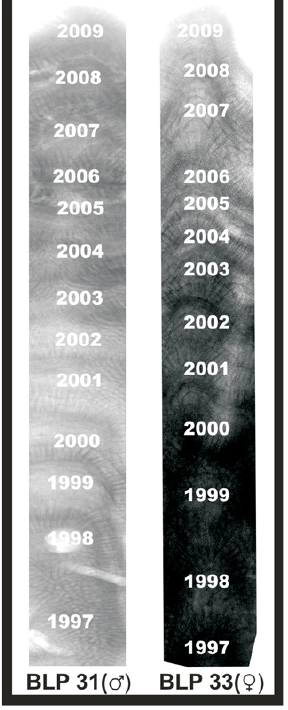
Figure 2. Positive X-Radiographs showing skeletal growth density band pairs of two Porites panamensis corals (one male and one fe- male) of Bahía de La Paz. The numbers on the image mark the years of the corresponding high-density